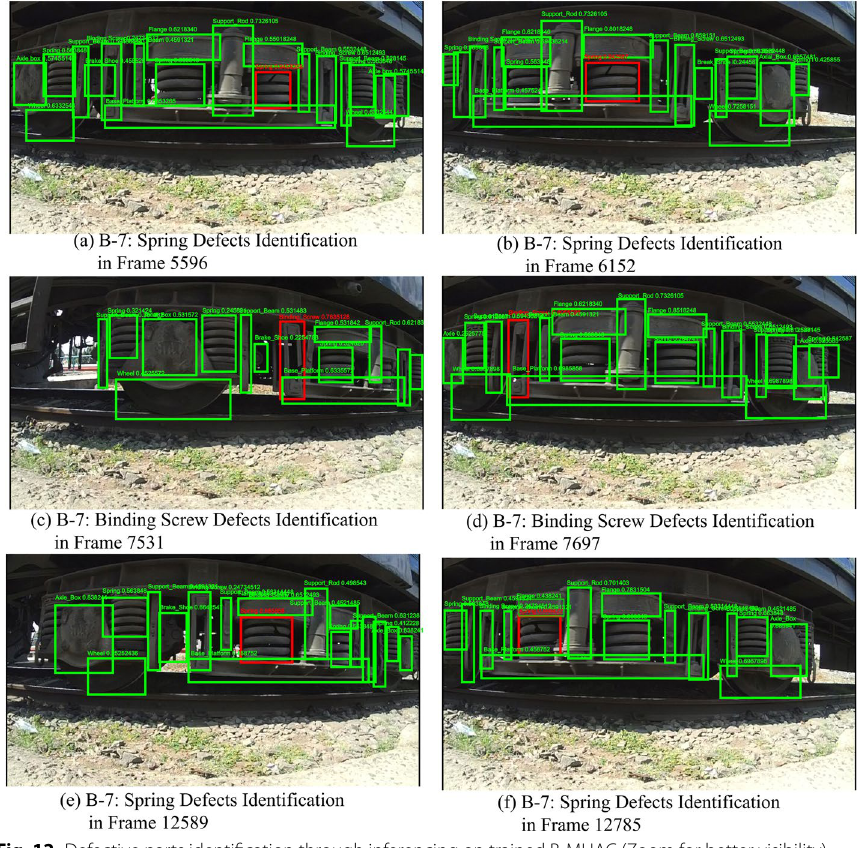
Fig. 12 Defective parts identification through inferencing on trained B-MHAC (Zoom for better visibility). a B-7: spring defects identification in frame 5596. b B-7: spring defects identification in frame 6152. c B-7: